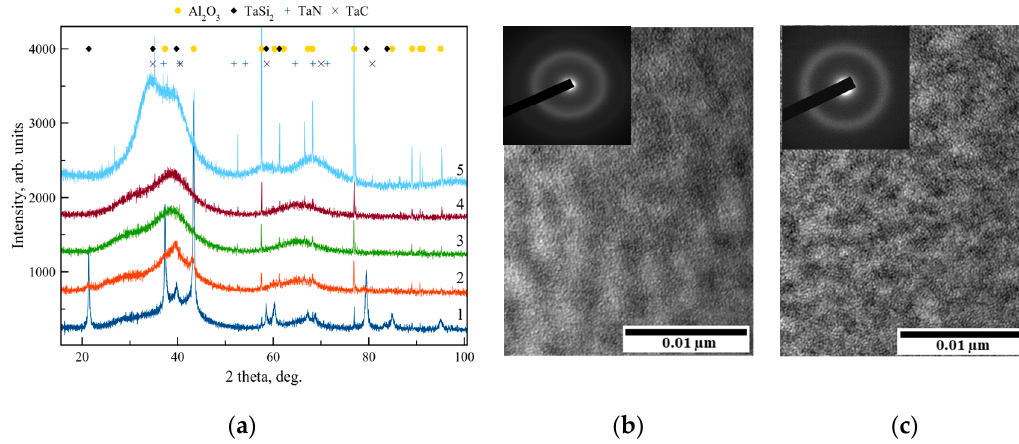
Figure 3. X-ray diffraction analysis (XRD) patterns of coatings 1(Ar), 2 (5 sccm N 2 ), 3 (10 sccm N 2 ), 4 (5 sccm C 2 H 4 ), and 5 (10 sccm C 2 H 4 ) deposited onto alumina substrate ( a ); selected area electron diffraction (SAED) and high-resolution transmission electron microscope (HR TEM) image of coatings 3 (10 sccm N 2 ) ( b ) and 5 (10 sccm C 2 H 4 ) ( c ).